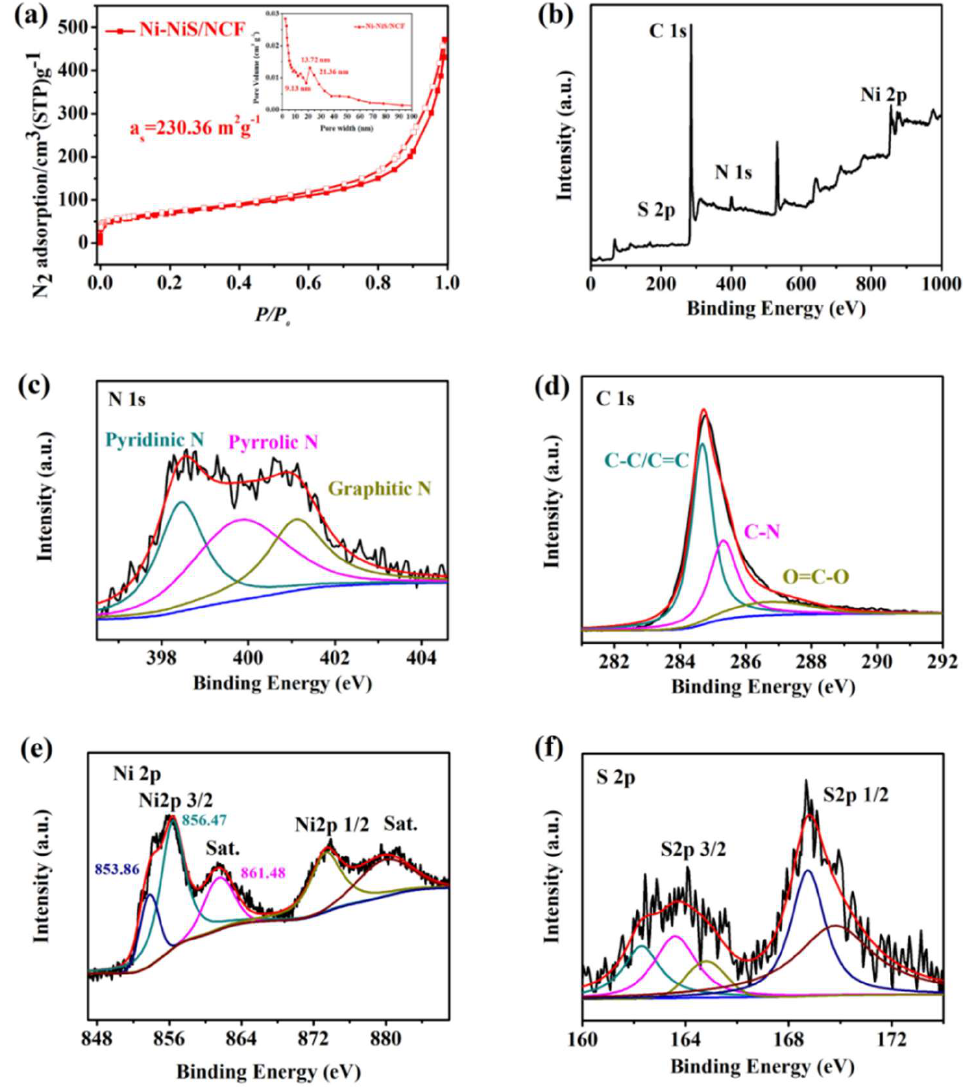
Figure 3. ( a ) Nitrogen adsorption and desorption isotherms of Ni-NiS/NCF; ( b ) total spectra of Ni-NiS/NCF; High resolution ( c ) N 1s XPS spectrum; ( d ) C 1s XPS spectrum; ( e ) Ni 2p XPS spectrum; ( f ) S 2p XPS spectrum.